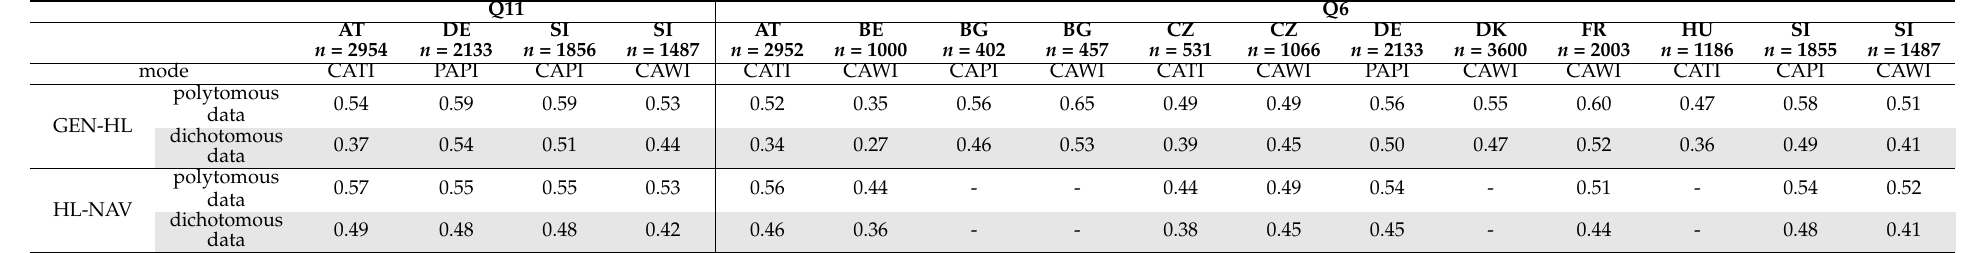
Table 7. Correlation between COM-HL scores (based on HLS 19 -COM-P-Q11 to the left and HLS 19 -COM-P-Q6 to the right) and general (GEN-HL) and navigational (HL-NAV) health literacy scores, based on polytomous and dichotomous (marked in grey) data. Results are divided by country and data collection mode. Q11 Q6 AT DE SI SI AT BE n = 2954 n = 2133 n = 1856 n = 1487 n = 2952 n =